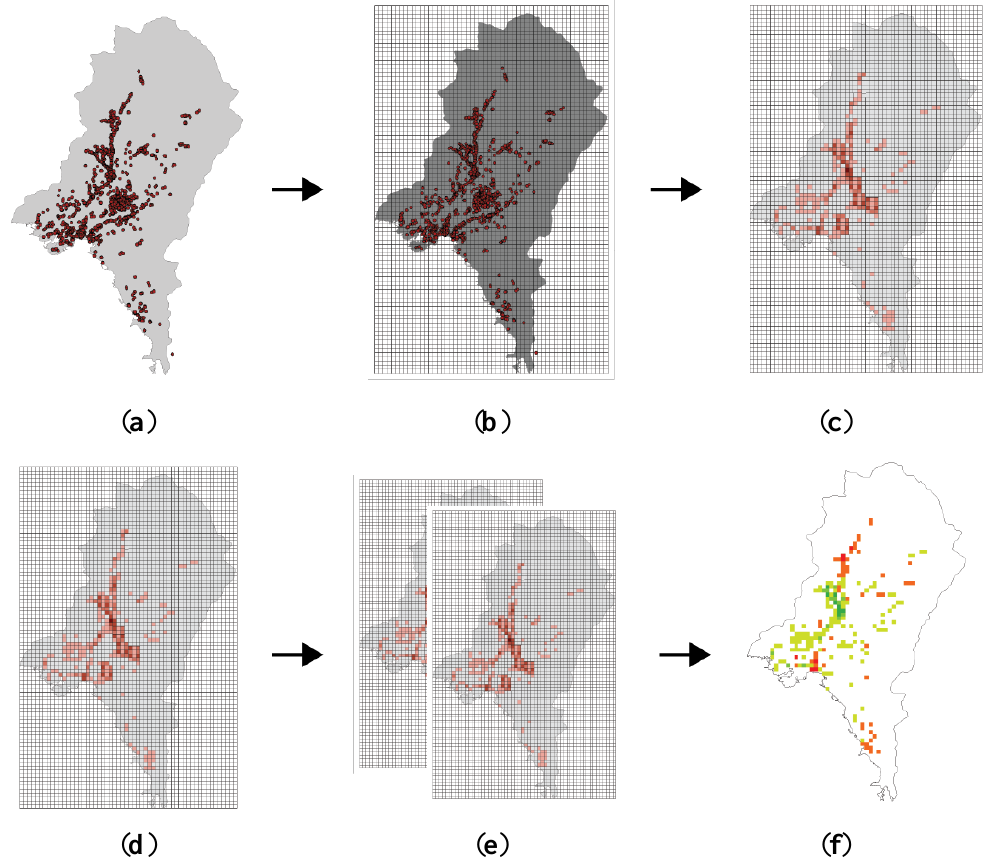
Figure 3. Basic steps of the methodology. ( a ) Mapping incident locations for each period. ( b ) Development of grid. ( c ) Incident count on a cell-by-cell basis for each period. ( d ) Assignment of cell values based on the incident count. ( e ) Subtracting grids of different periods on a cell-by-cell basis. ( f ) Result of subtraction showing increase or decrease in cell